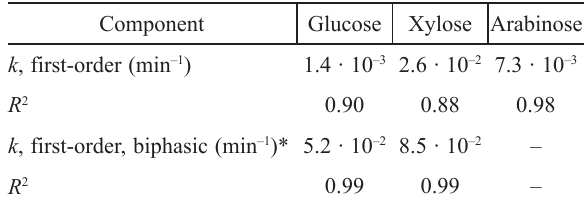
6 – Model parameters for the hydrolysis with 1.5 % (w/w) sulfuric acid, at 120 °C and with 7 % (w/w) dry matter on arabinose reduced corn stover on a pilot scale